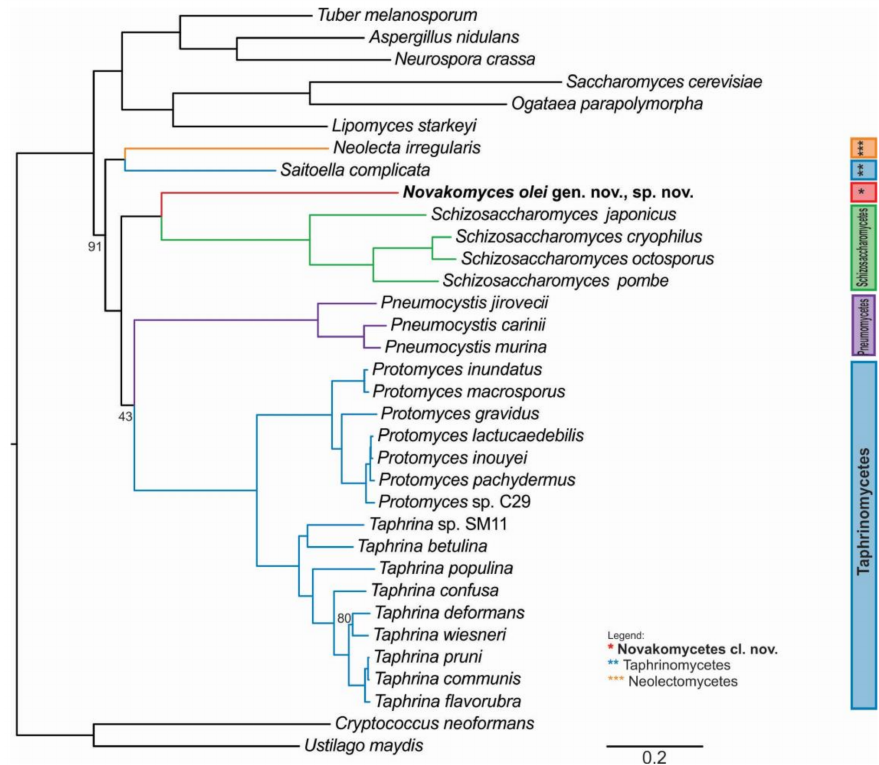
Figure 2. The phylogenetic relationships of Taphrinomycotina and related fungi based on concatenated alignment of 110 orthol- ogous, single-copy BUSCO gene amino acid data matrix. The maximum likelihood (ML) phylogeny was reconstructed under the LG + GAMMA substitution model using RAxML as determined by IQ-TREE as the best model for a given dataset. Branch support values are indicated only for the nodes with <95% bootstrap support. Scale bar, number of amino acid substitutions per site. Cryptococcus neoformans and Ustilago maydis were the designated outgroup species in the